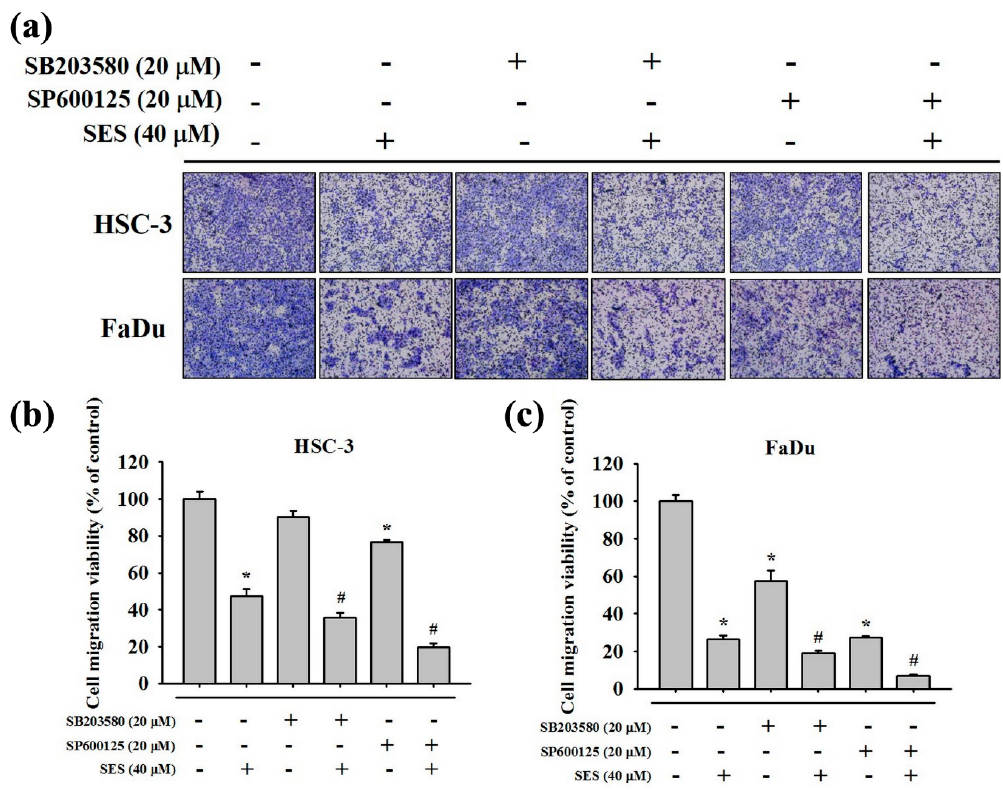
Figure 8. The relationship between cell migration and MAPK inhibitors in human oral cancer cells following sesamin treatment. ( a ) HSC-3 and FaDu cells were pretreated with SP600125 or SB203580 for 1 h and then incubated in the presence or absence of 40 μ M SES for 24 h. After that, transwell assays were performed as described in the “Material and Methods” section. ( b ) Quantitative results for the HSC-3 cell line, determining the number of cells that migrated to the underside of the porous polycarbonate. ( c ) Quantitative results for the FaDu cell line, determining the number of cells that migrated to the underside of the porous polycarbonate. The values represent the means ± SD of at least three independent experiments. * p < 0.05, compared with the control group. # p < 0.05, compared with the SES-treated group.